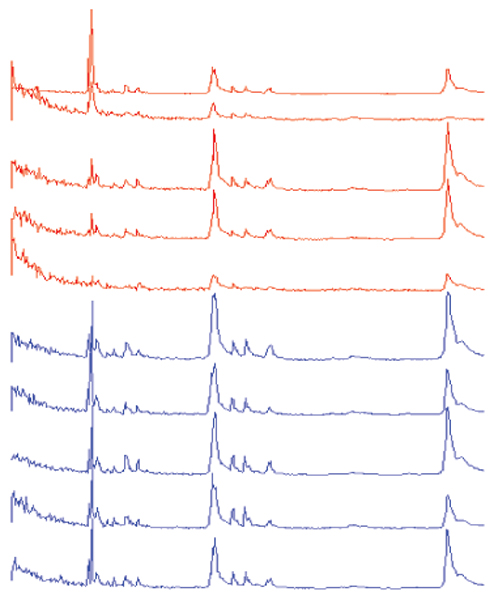
Representative examples of SELDI spectra from quality control samples. Examples of spectra illustrate differences between highly consistent spectra and low quality spectra. The spectra in blue are examples of the highly consistent spectra, which include the majority of the 144 quality control samples. All spectra have very similar peak patterns as could be expected for the biological replicates of quality control samples. This indicates that the experiments were conducted consistently and that the spectra are of high quality. In contrast, the spectra in red are the low quality spectra detected by the correlation matrix and that need to be discarded prior to data analysis. All of the low quality spectra are different from the high quality spectra in terms of the peak patterns. Furthermore, unique peak patterns do not exist among the low quality spectra.